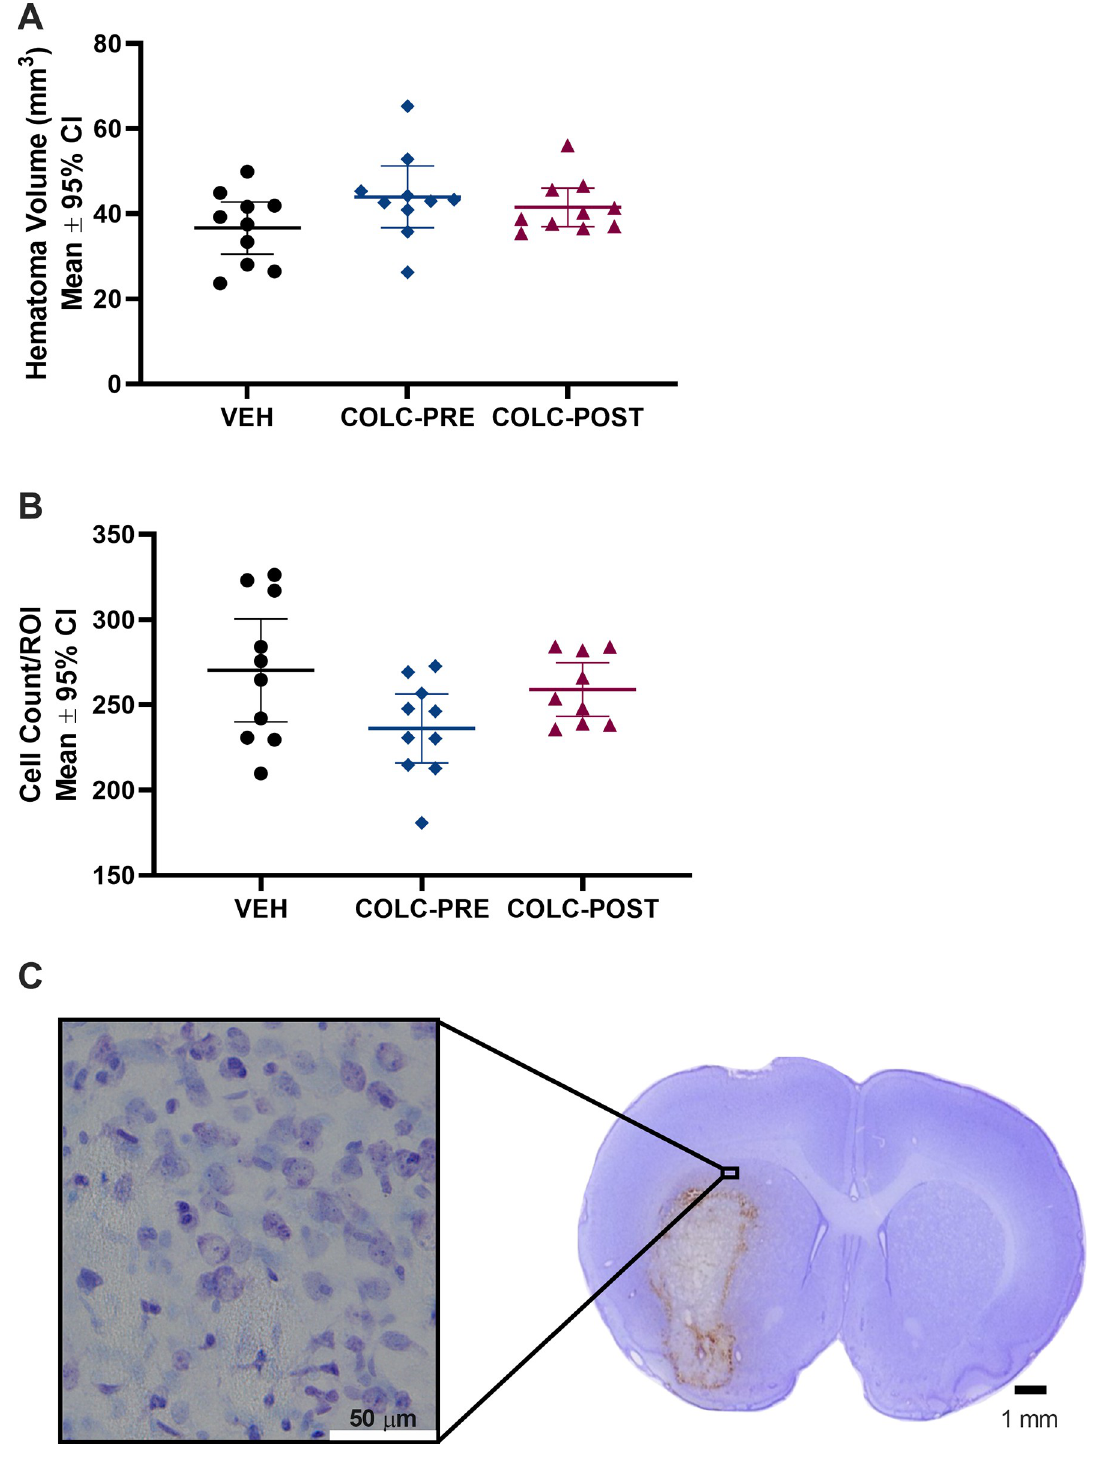
Fig 3. Experiment 2 hematoma volume and cell counts. No differences in hematoma volume (A, p = 0.168), or cell density in the peri-hematoma zone (B, p = 0.071) were found at 48 hours post-ICH. C. Representative image of neurons in the PHZ stained using cresyl violet. White scale bar represents 50 μ m, black scale bar represents 1